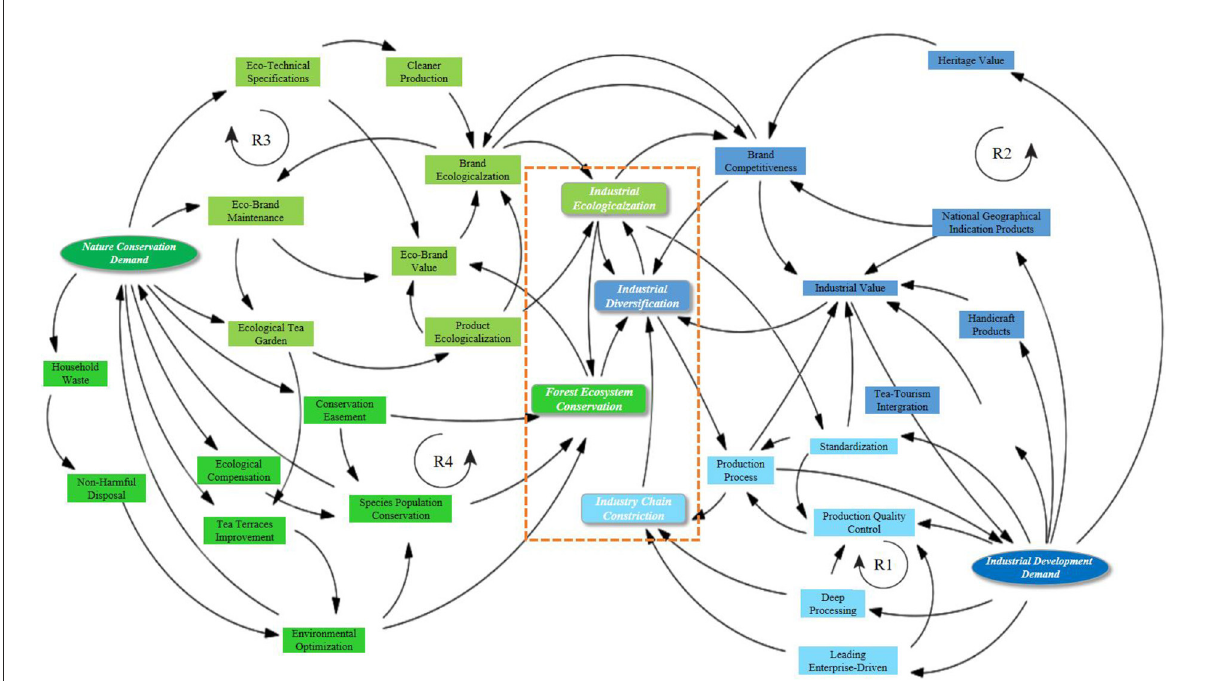
FIGURE3 Dynamic mechanism of tea industrial transformation in Wuyishan National Park. Note: Green represents ecologicalization and blue represents industrialization. The spectrum from light to dark color represents the incremental degree of industrialization or ecologicalization. The ovals represent conservation or development demand, the rectangles represent variables of solutions in the causal loop. The rounded rectangle represents the causal loop theme, which is also the direct goal of solutions, and they formed the synergistic goal of industrial development and nature conservation. The arrows represent the causal loop transmission of “demand-solution-goal.” The consistent color represents the same causal